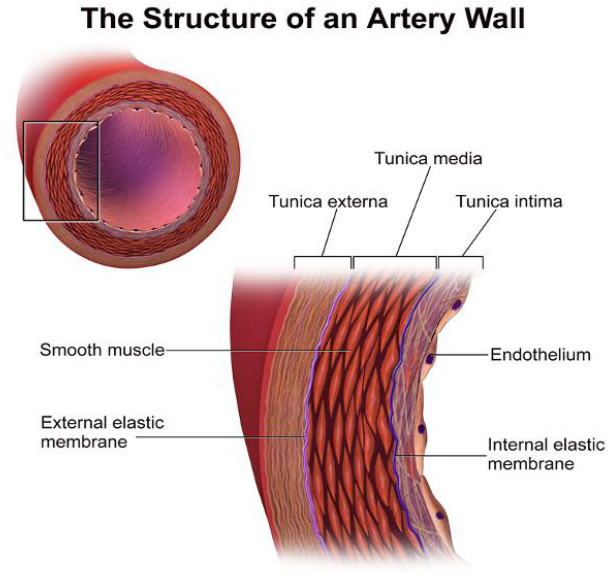
Figure 1. The structure of an artery wall. VSMCs are located in the tunica media, while endothelial cells are mostly in the tunica intima [26].